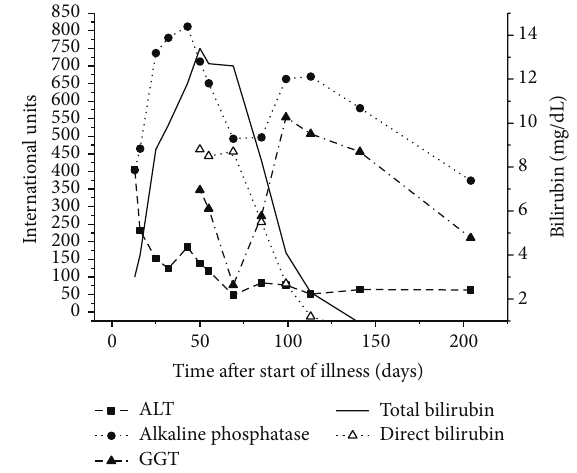
Figure 1: Evolution of laboratory values of liver function tests of patients with